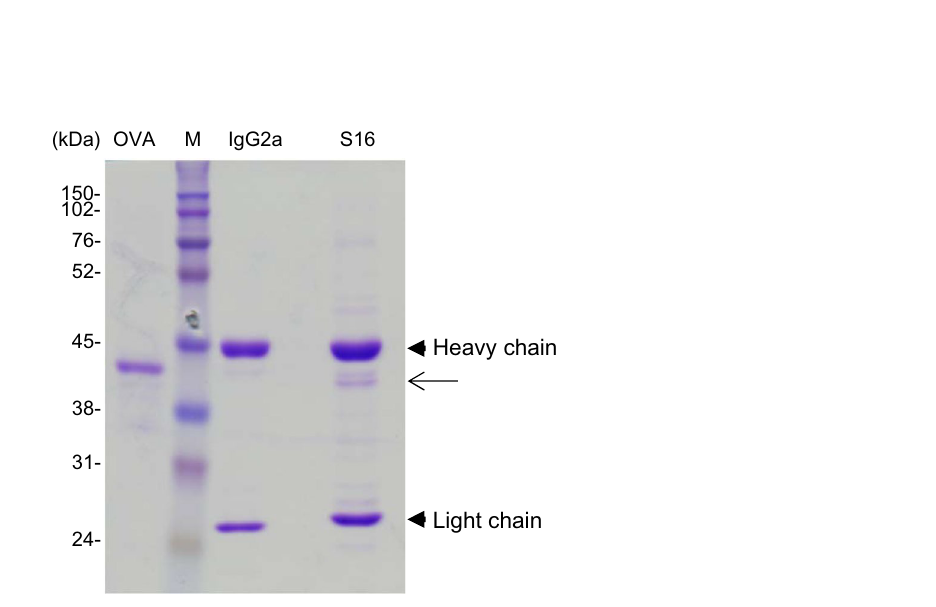
Figure 4. Immunoprecipitation of S16-binding protein. Liver proteins (200 μg) were immunoprecipitated with IgG2a isotype control or S16 using protein A dynabeads at room temperature for 15 min. The immunoprecipitated proteins and ovalbumin (OVA, 44.3 kDa) were electrophoresed using SDS-PAGE on 12% gels and visualized using CBB staining. The band of interest (arrow) was cut and subjected to MS analysis. Molecular weight markers (M) are separated, and the sizes are shown at the left of the gels (kDa). The image is the representative result of three independent